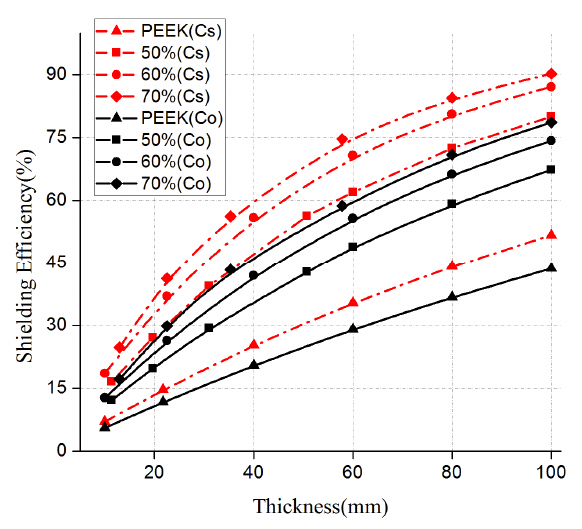
Figure 20. The black and red curves represent the gamma ‐ ray shielding effects under 60 Co and 137 Cs sources, respectively.